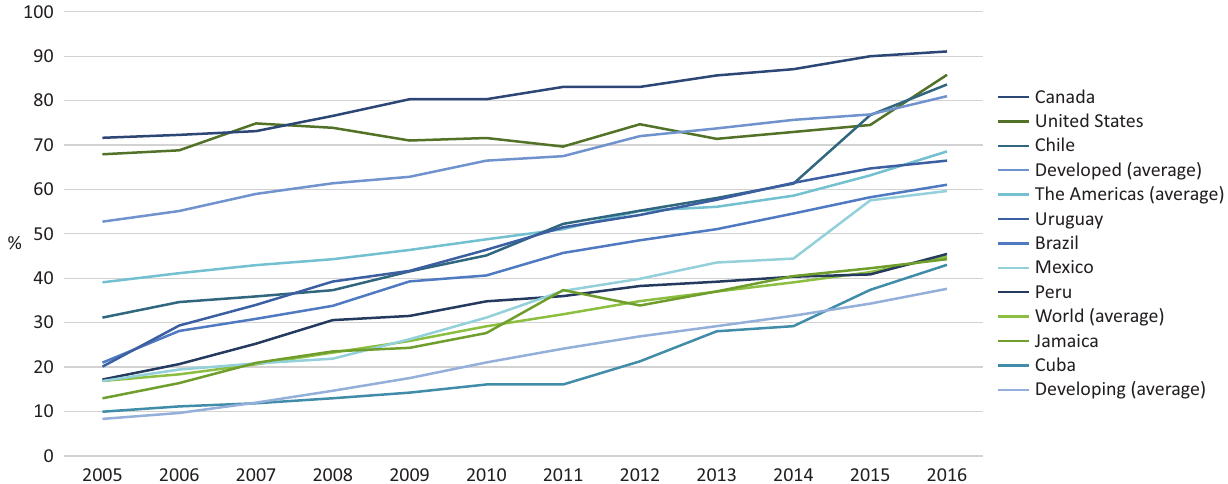
Figure 3. Individuals using the internet (percentages), 2005–2016. Assembled by author Matias Dodel with data from ITU